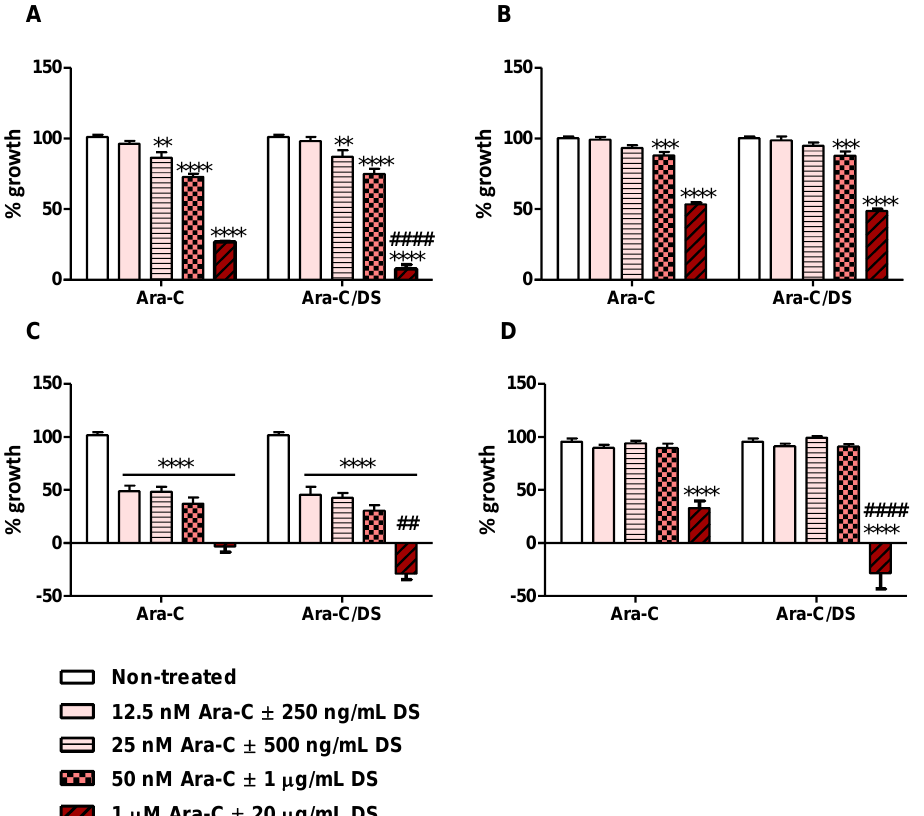
Figure 5. Cytostatic potential of AraC/DS. Cell growth of ( A ) HCT 116, ( B ) HT29, ( C ) A2780 and ( D ) A2780R treated with titrated doses of AraC or AraC/DS for 48 h was assessed by SRB assay (data presented as the average of two independent experiments performed in triplicate, n = 6 ± SEM). Statistical differences were calculated by twoway ANOVA with Bonferroni multiple comparison post hoc tests where **** p < 0.0001, *** p < 0.001, and ** p < 0.01 and compared each doses to the non-treated condition, and #### p < 0.0001 and ## p < 0.01 compared Ara-C/DS to Ara-C at the respective dose.